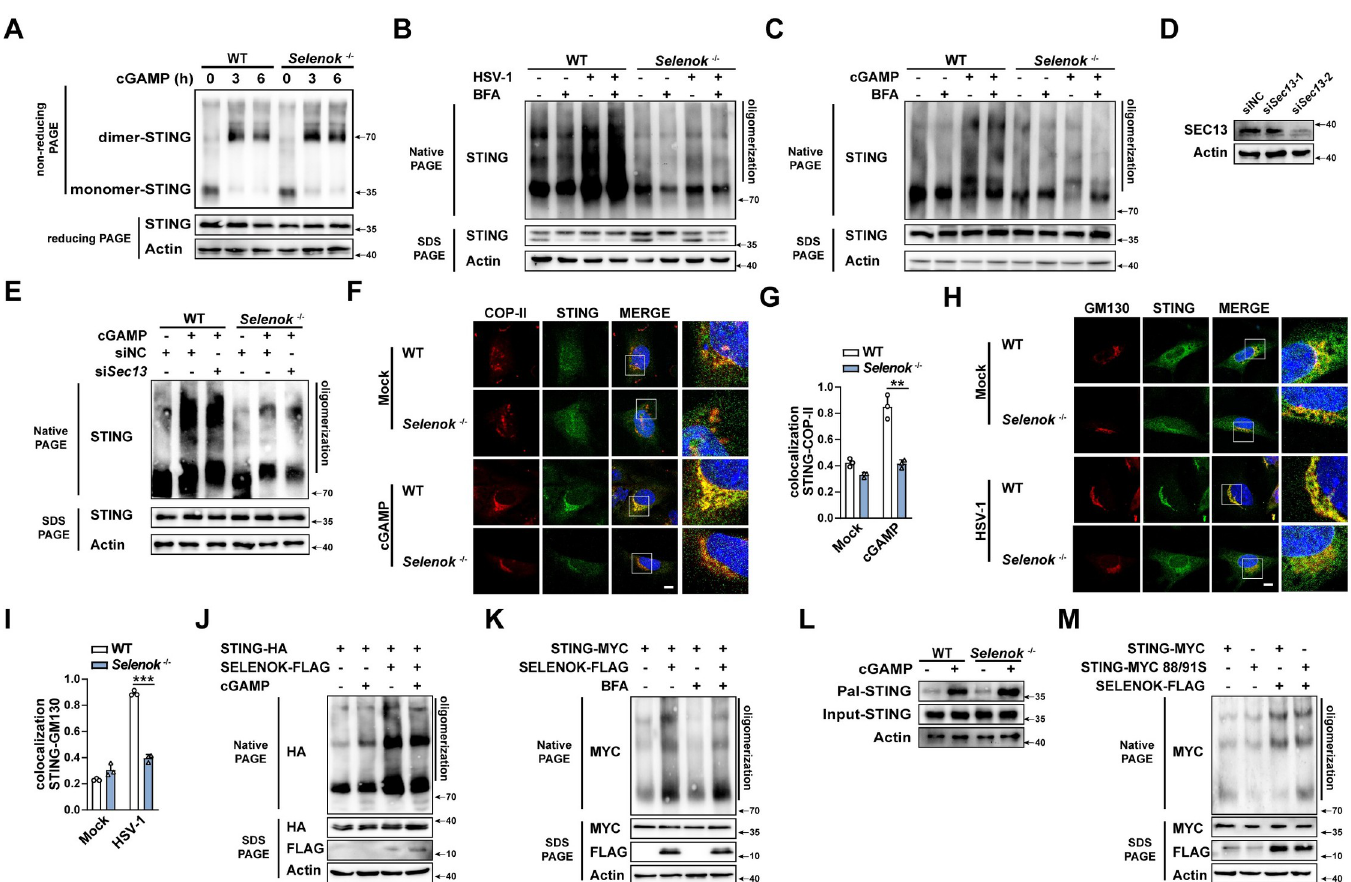
Fig 6. SELENOK enhances the oligomerization of STING. (A) Immunoblot analysis of STING dimerization in PMs stimulated by cGAMP. (B) Immunoblot analysis of oligomerization of STING in PMs stimulated by BFA, HSV-1, or BFA plus HSV-1. (C) Immunoblot analysis of oligomerization of STING in PMs stimulated by BFA, cGAMP, or BFA plus cGAMP. (D) Immunoblot analysis of SEC13 expression in PMs transfected with siRNA (siNC, si Sec13 -1 and si Sec13 -2). (E) Immunoblot analysis of oligomerization of STING in PMs stimulated by cGAMP after transfection with siRNA (siNC, si Sec13 -2). (F) Immunofluorescence analysis of MEF stimulated with cGAMP using anti-STING (green) and anti-COP-II (red) antibodies and DAPI nuclear staining. Scale bar,10 μ m. (G) Colocalization analysis of STING and COP-II by Manders’ Colocalization Coefficients (MCC). (H) Immunofluorescence analysis of MEF stimulated with HSV-1 using anti-STING (green) and anti-GM130 (red) antibodies and DAPI nuclear staining. Scale bar,10 μ m. (I) Colocalization analysis of STING and GM130 by Manders’ Colocalization Coefficients (MCC). (J) Immunoblot analysis of STING oligomerization in HEK 293T cells transfected with STING-HA and control vector plasmids or SELENOK-FLAG, followed by stimulation with cGAMP. (K) Immunoblot analysis of STING oligomerization in HEK 293T cells transfected with STING-MYC, the control vector or SELENOK-FLAG, and then stimulated by BFA or not. (L) Immunoblot analysis of STING palmitoylation in PMs stimulated by cGAMP. (M) Immunoblot analysis of STING oligomerization in HEK 293T cells transfected with STING-MYC, STING-MYC C88/91S, the control vector, and SELENOK-FLAG. Statistical significance was determined by unpaired two-sided multiple Student’s t-tests in G and I. Data represent mean ± standard deviation (SD) or one representative image from three independent experiments. ** P: < 0.01, *** P: < 0.001. siNC, control siRNA; si Sec13 -1; si Sec13 -2 (S1 Table). STING oligomerization. The results showed that the C88S and C91S mutants do not affect SELENOK-induced STING oligomerization (Fig 6M). The palmitoylation of STING is impor- tant for its trafficking and oligomerization [13], but it is unknown whether the palmitoylation of STING occurs in the endoplasmic reticulum or the Golgi apparatus and whether the traf- ficking of STING directly affects its palmitoylation. Thus, our results indicated the function of SELENOK in STING oligomerization in a palmitoylation-independent manner. Taken together, these data suggest that SELENOK enhances the oligomerization of STING in the ER and licenses its trafficking from the ER to the Golgi complex.